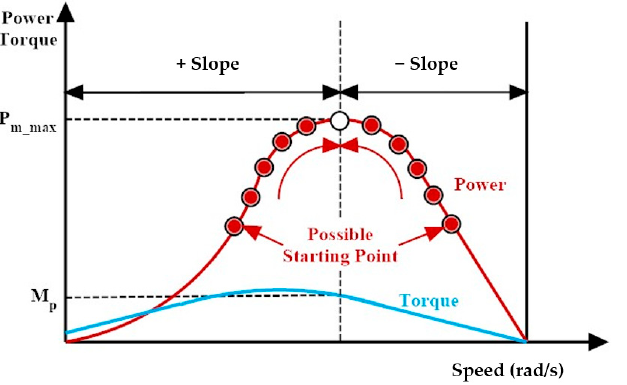
Figure 12. Wind turbine output power and torque characteristics with MPPT tracking process [51]. 443